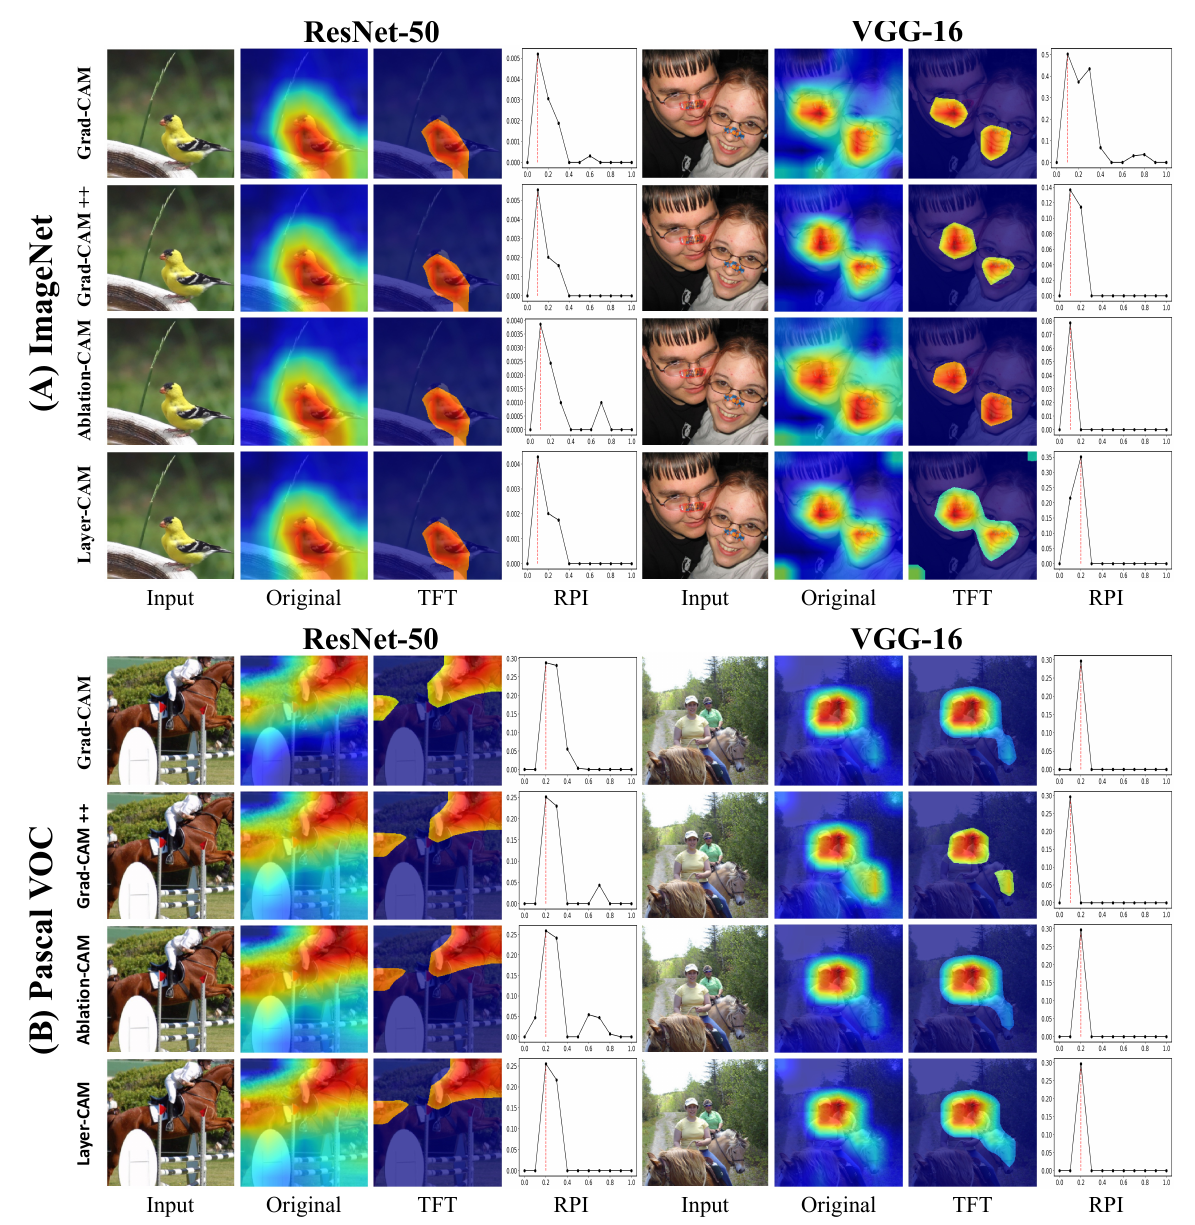
Figure 3. Qualitative comparison of the original attribution map and thresholded attribution map by threshold fine-tuning (TFT). The input images, the original attribution maps, and thresholded attribution maps are shown, along with the RPI curves over threshold values in [ 0,1 ] with an increment of 0.1. The best threshold values are depicted with the red dotted lines in the RPI